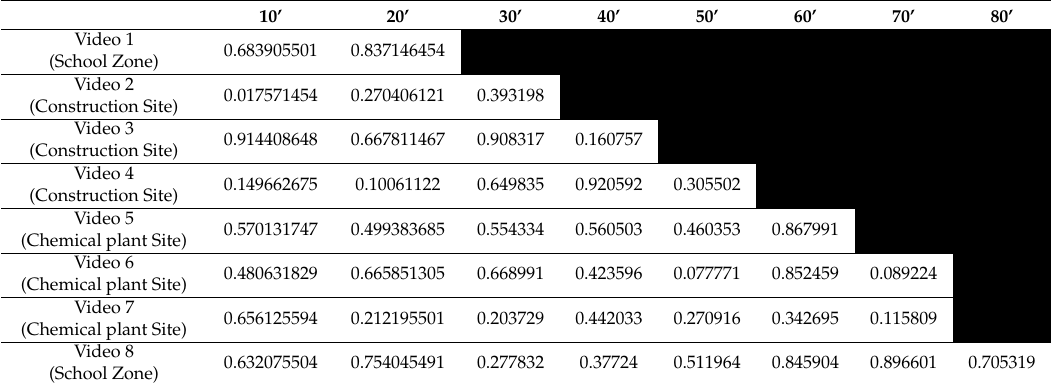
Table 4. Average safety score of each video at specific